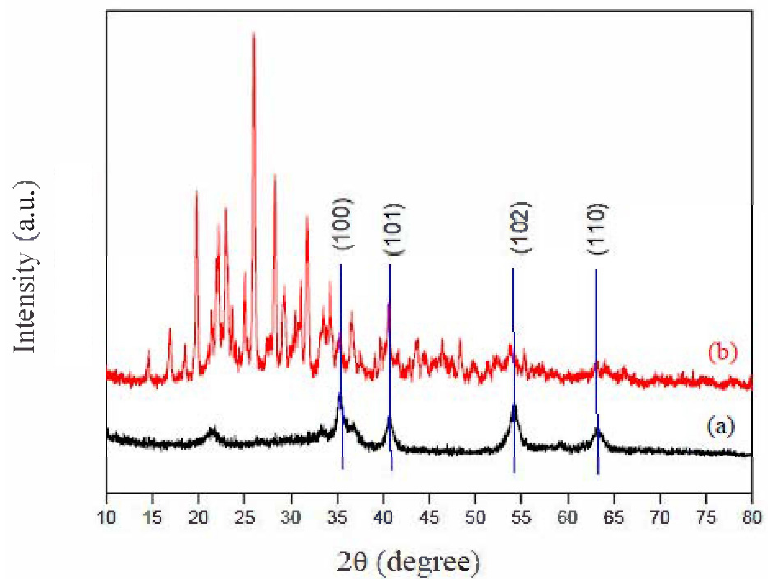
Figure 4. XRD patterns of ( a ) δ -FeOOH and ( b ) ABT/ δ -FeOOH materials. Theoretical Studies